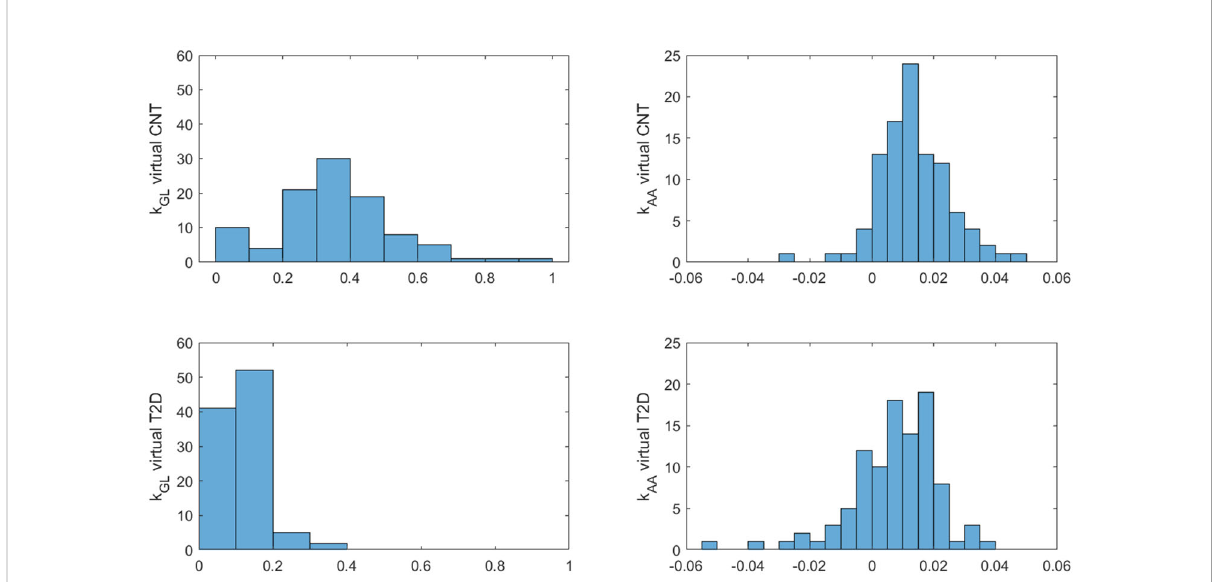
FIGURE 9 Distributions of k GL and k AA over the 100 virtual CNT and T2D